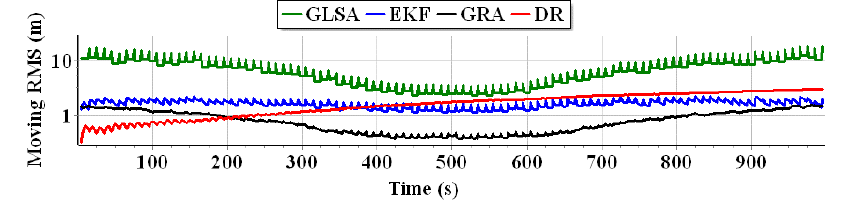
Figure 21. Moving RMS of distance to reference position from the estimated position during 100 SV crossings as a function of time (logarithmic scale—log base =